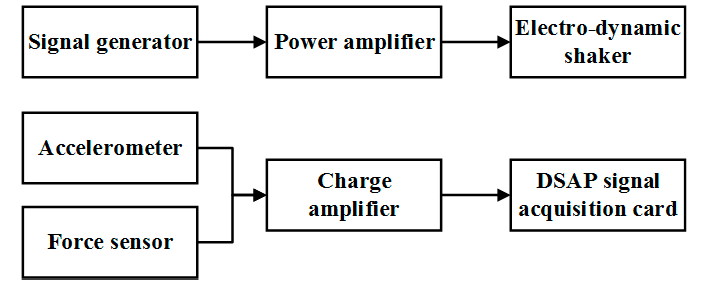
Figure 14. Block diagram of the excited and measured analysis system. Table 2. Experimental results of the vibration level difference under different exciting forces with the cell thickness t = 1 mm (dB).